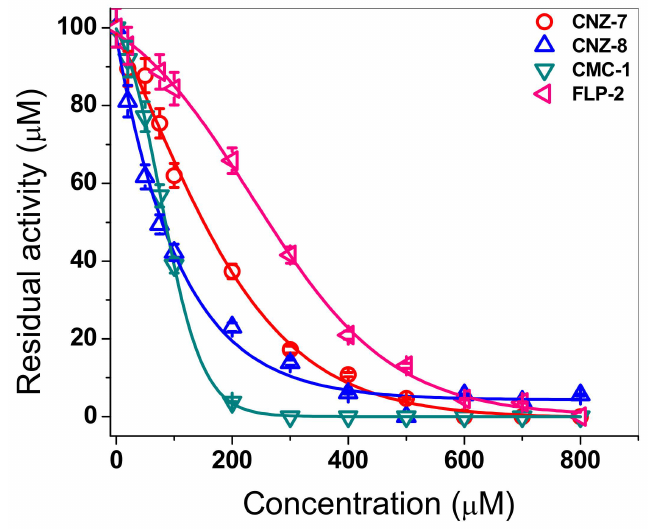
Figure 2. Effects of CNZ-7, CNZ-8, CMC-1, and FLP-2 chemical compounds on the activity of G6PD::6PGL enzyme. G6PD::6PGL protein was adjusted at 0.2 mg/mL and incubated in the presence of different concentrations of compounds (0–800 µ M). After incubation, aliquots were withdrawn from the samples, and the residual activity was determined. The G6PD::6PGL without compounds was used to determine 100% activity. The assays were carried out in triplicate, and the data represent the mean ± standard error.